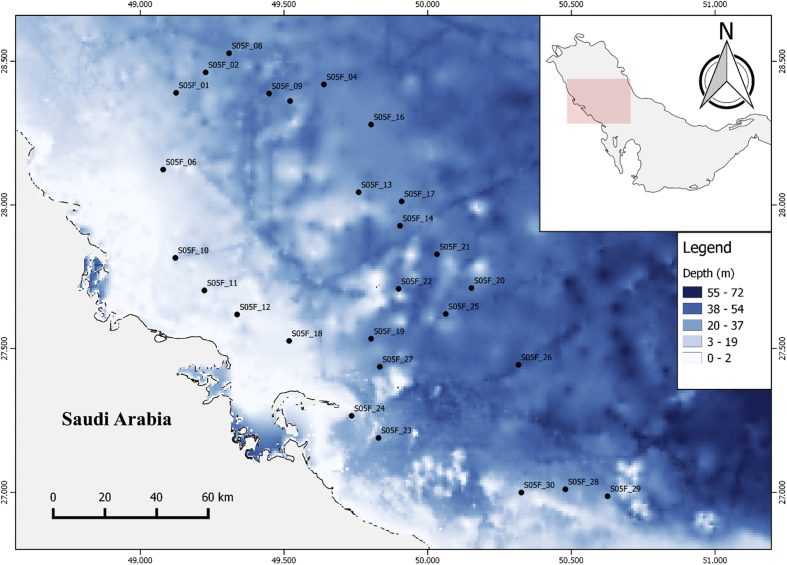
Sampled area with a detailed bathymetry profile. Coordinates (DMS) are provided in Appendix 1-1.